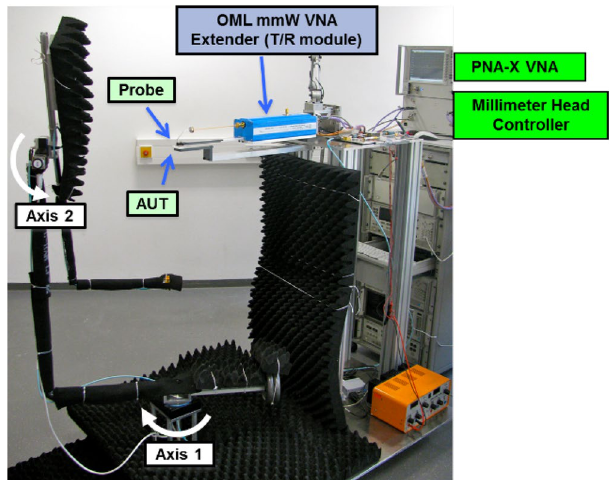
Figure 6. The used probe based free-space measurement setup.